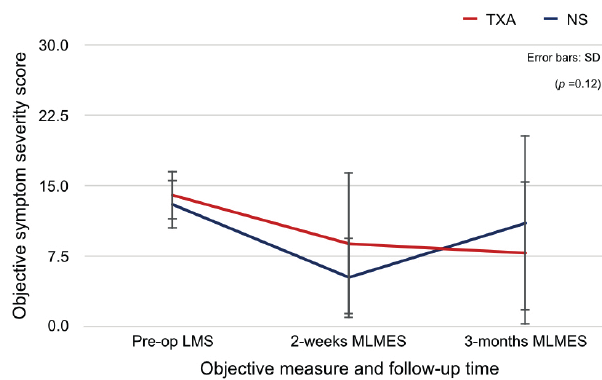
Figure 3. Subjective symptom score. (SNOT-22) Over time SNOT-22 = 22-item Sino-Nasal Outcome Tool; TXA = Topical Tranexamic acid; NS= topical normal saline: Error bars indicate standard deviafion (SD); p values are based on Mixed Between-Within Subjects Analysis of Variance.